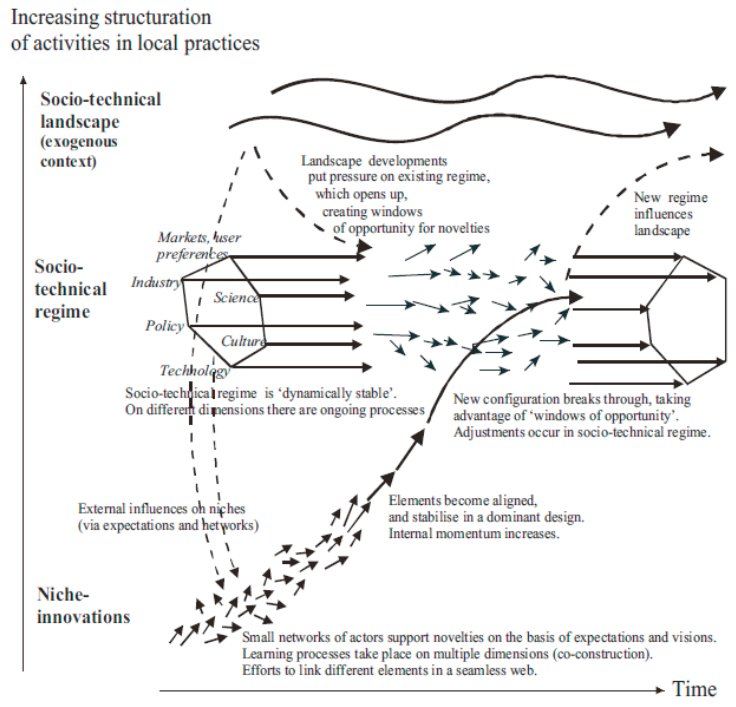
Figure 1. Multi-Level Perspective on transitions ([7] (28), adapted from [3] (1263)).